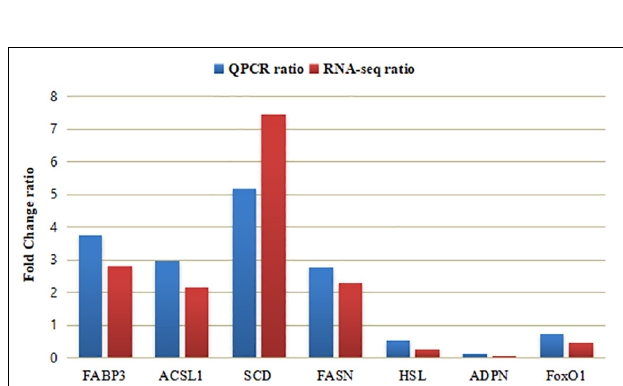
FIGURE 4 | Gene ontology (GO) annotation of differentially expressed genes.